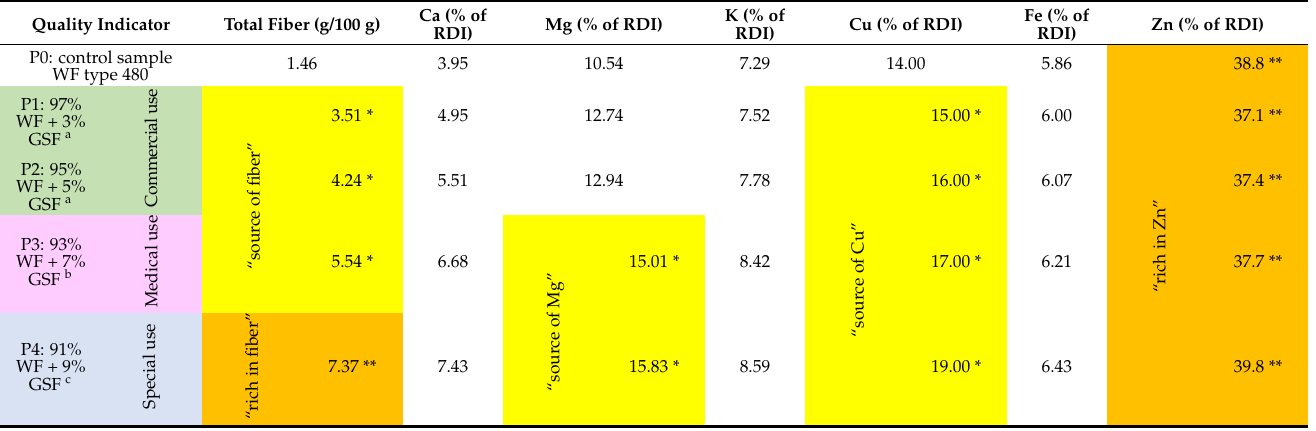
Table 11. Synthesis of nutritional indicators for the studied baking